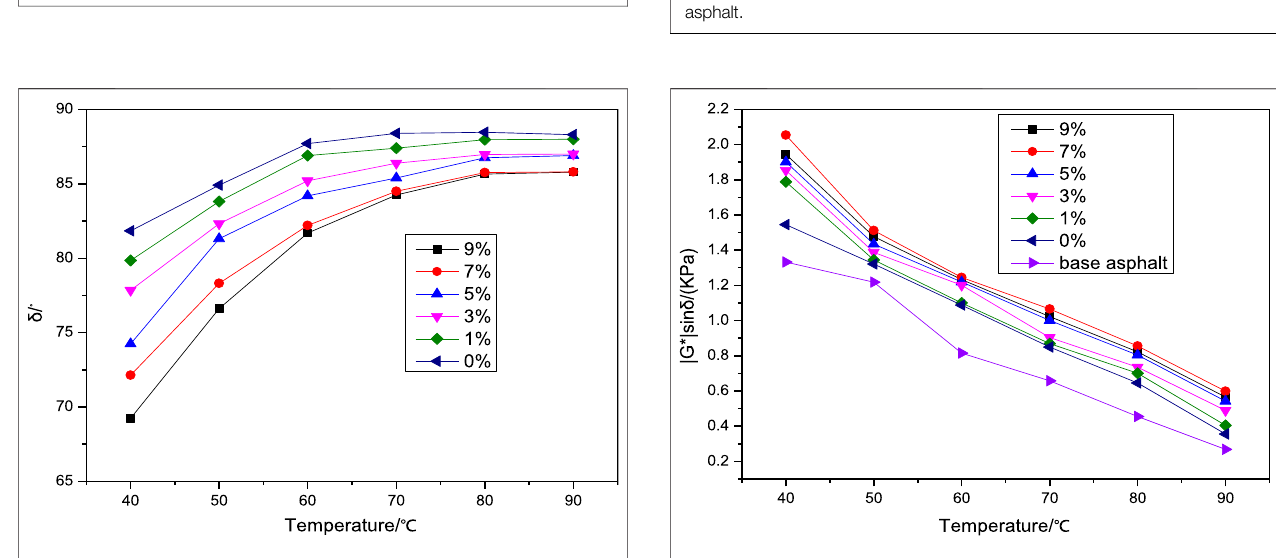
FIGURE 9 | Effect of PP-g-MAH content on |G*| of modi fi ed asphalt.